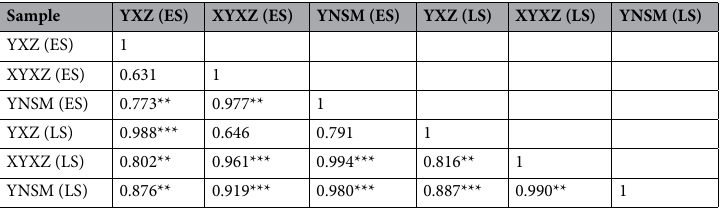
Table 3. Relationships between RVA profiles in different seasons. ES early season; LS late season ***Significance level at P < 0.001; **Significance level at P < 0.01.